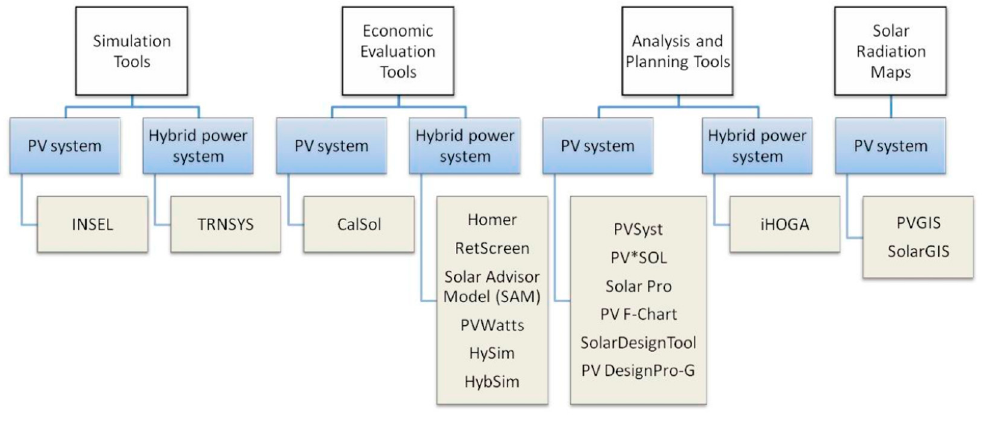
Figure 11. Simulation software classification [81].